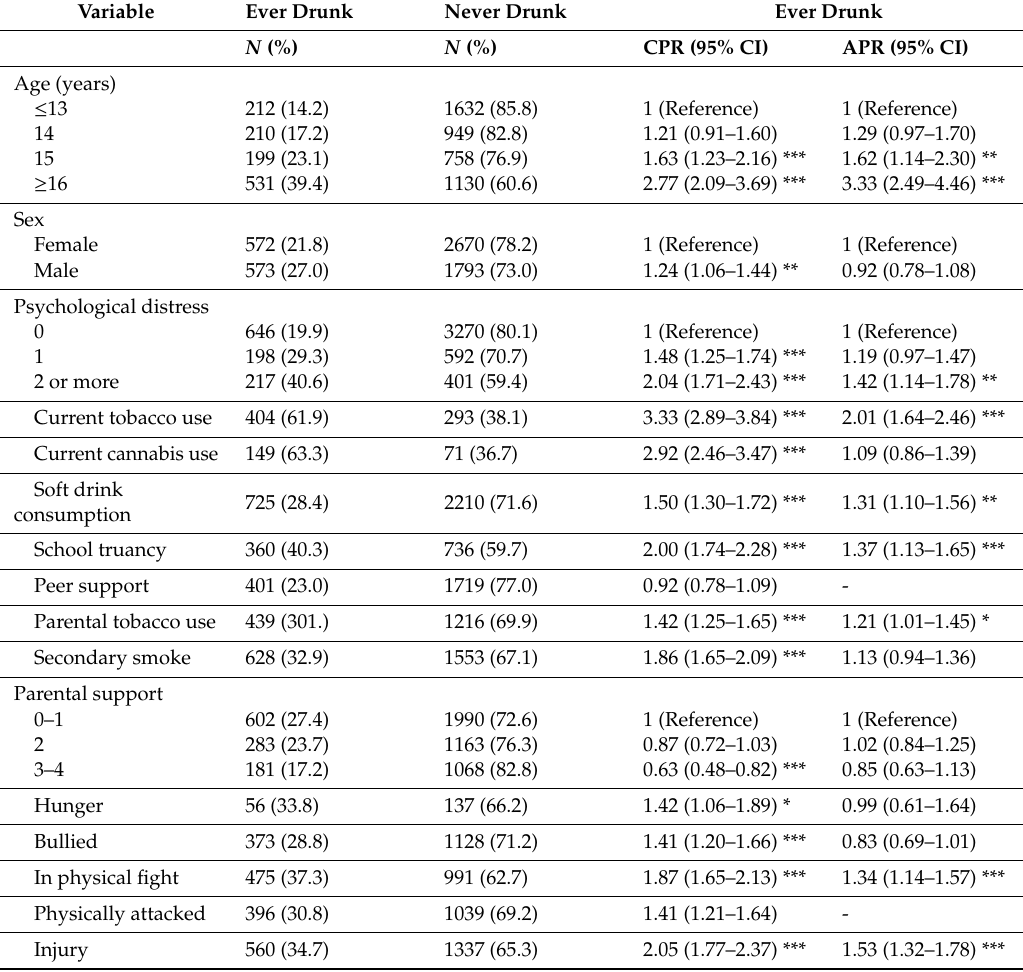
Table 4. Associations with ever having been